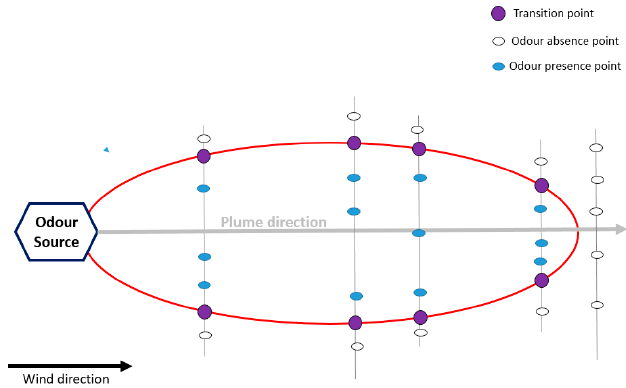
Figure 8. Stationary plume method—field inspection.